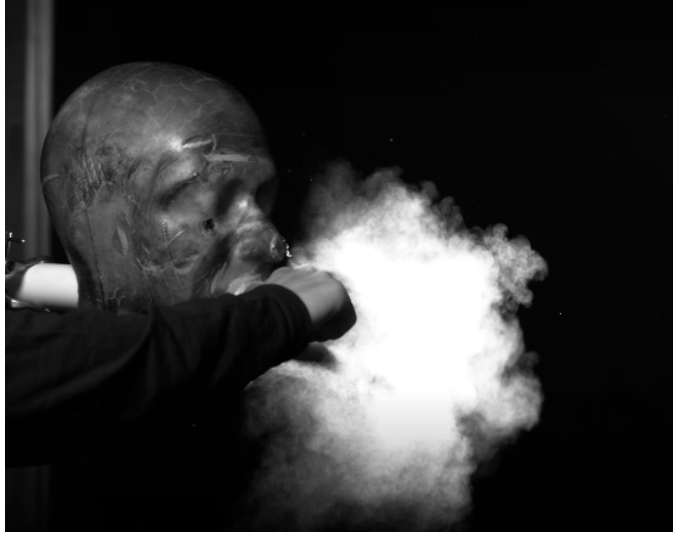
Figure 8. High-speed backlit photographs of the cough with balled fist. Compared to intervention with a bare elbow, a sleeved elbow appears to entrap some of the particles thus reducing the particle cloud size and directing it in an upward manner (Figure 9A). An elbow pressed up close to the mouth or origin of the cough appears to visually reduce forward contamination compared to an unmitigated cough and the bare elbow (test C), deflecting much of it back towards the face of the person coughing. See Figure 9B. Figure 9. High-speed backlit photographs of the cough with ( A ) a sleeved elbow and ( B ) the elbow touching the mouth. 3.3. Viral Survival and Transfer into the Environment Following Interventions Fluorescence visualisation demonstrated that in all of the simulated scenarios saliva and bodily fluids were present on each surface contacted. This was consistent across both test runs performed and is shown in Figure 10A,B.